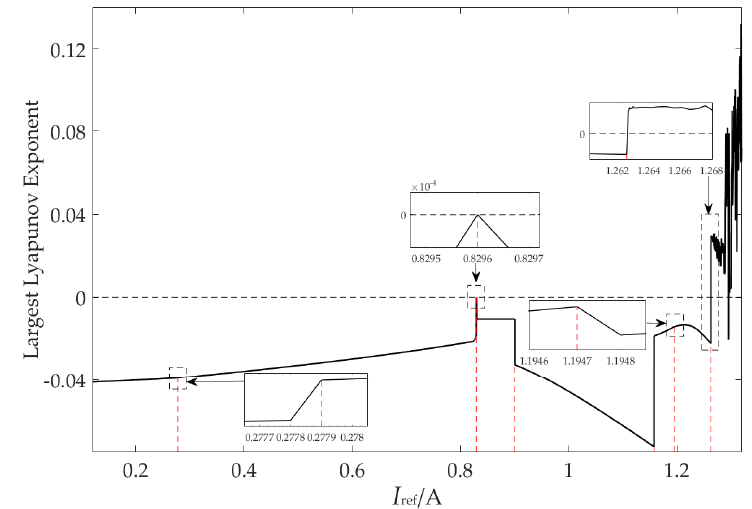
Figure 9. Sample Entropy of buck converter with I ref as the change parameter